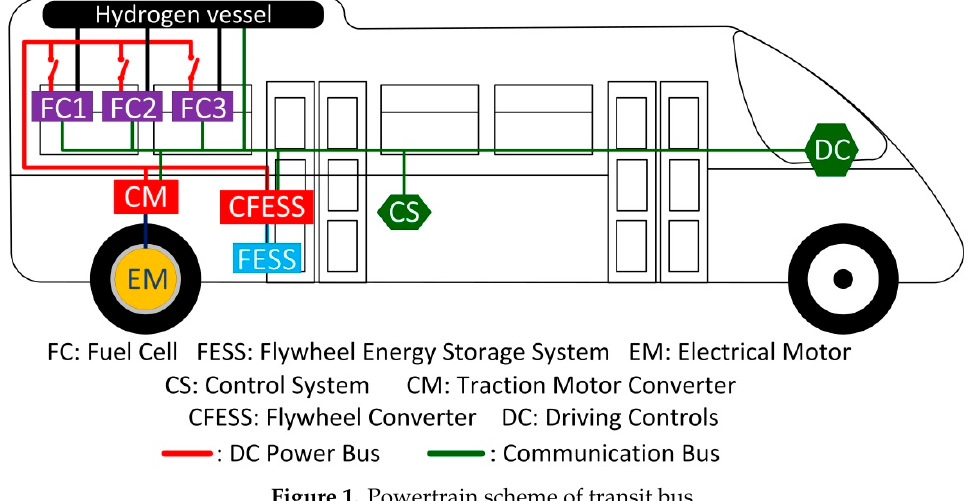
Figure 1. Powertrain scheme of transit bus.